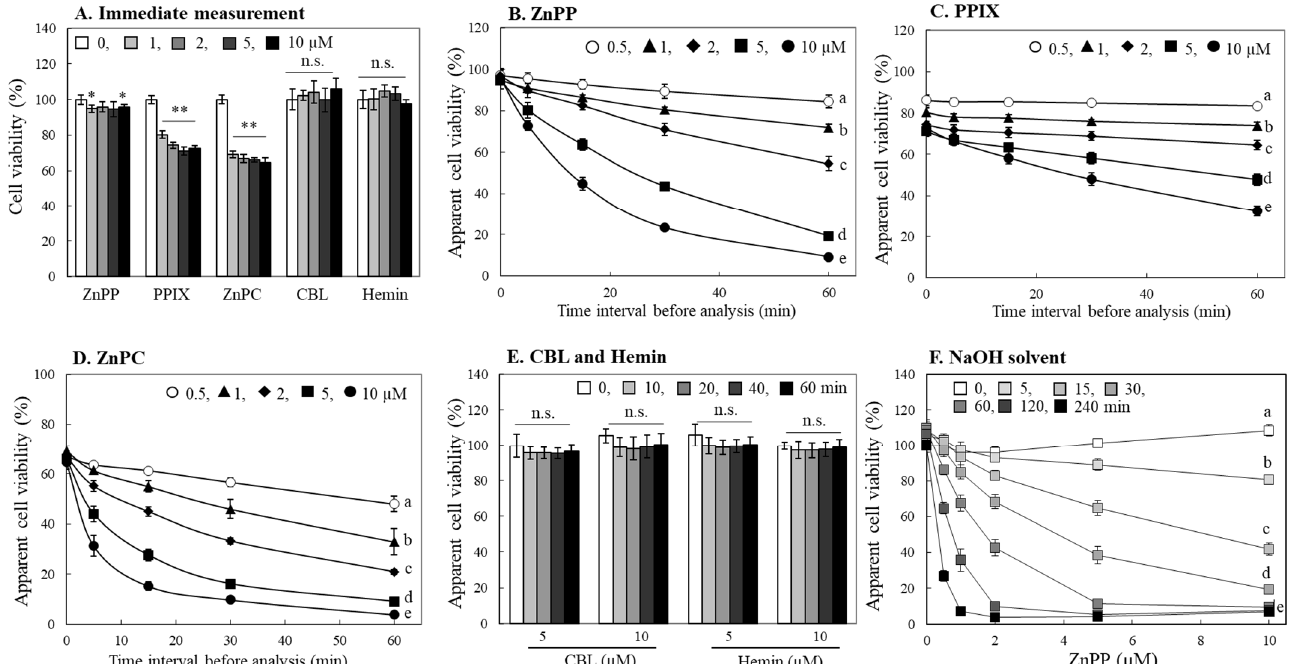
Figure 2. Changes in apparent viability of cells treated with porphyrin derivatives by the measurement time interval. INT407 cells were treated with different concentrations (0–10 μ M) of porphyrin derivatives for 24 h. The MTT assay was, then, performed immediately ( A ) or by changing the time interval from the lysis of cells treated with ZnPP ( B ), PPIX ( C ) ZnPC ( D ) using DMSO to the absorbance measurement (0–60 min). The effects of CBL and hemin (5 and 10 μ M) on apparent cell viability were also analyzed during 60 min of the time interval ( E ). Cells treated with different concentrations of ZnPP were lysed using 0.2 N NaOH and the formazan absorbance Dwas analyzed at different time interval ( F ). Each value represents the mean ± S.D. ( n = 8). *, ** Significantly different from control according to Student’s t ‐ test (*, p < 0.05; **, p < 0.01). Different letters indicate a significant difference among samples ( p < 0.05) based on one way ANOVA and the Tukey’s HSD test. n.s., not